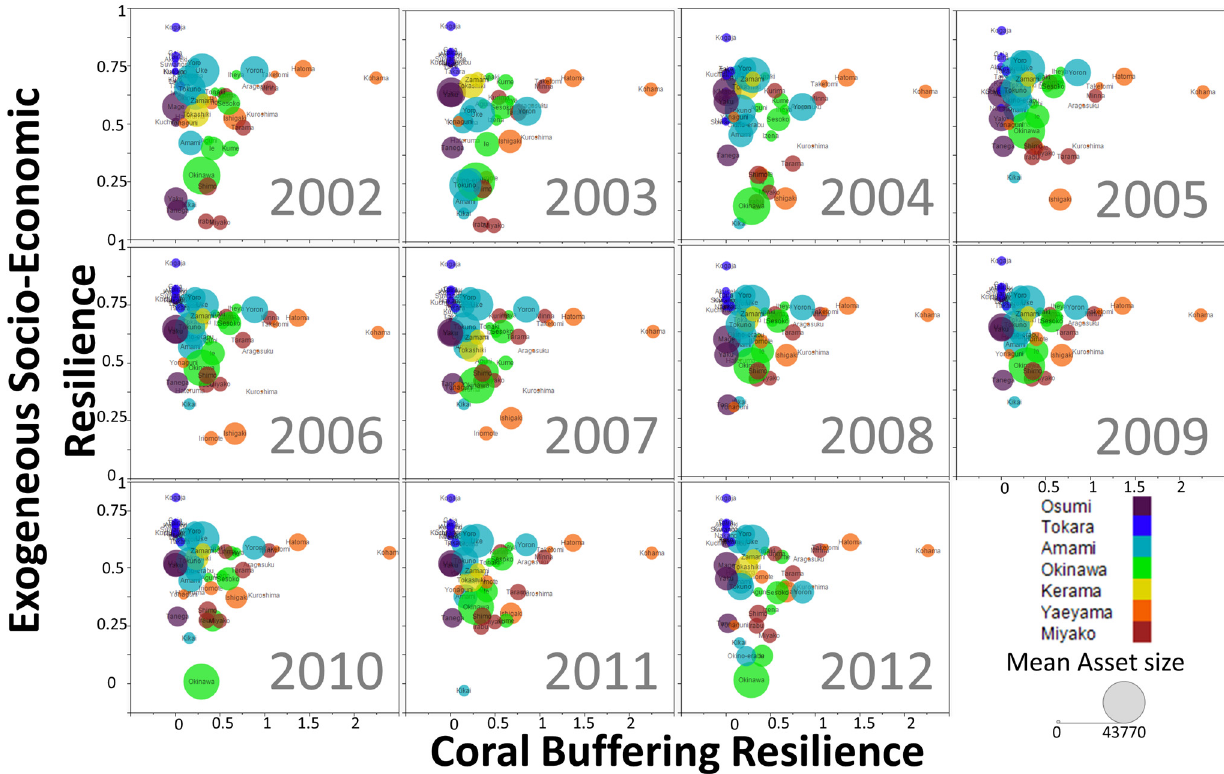
Figure 8. Island-scale bubble plots of the exogenous socioeconomic resilience with the coral buffering resilience. The bubble size represents the mean asset (¥ · m − 2 ), and the colors represent the Nansei sub-archipelagoes during